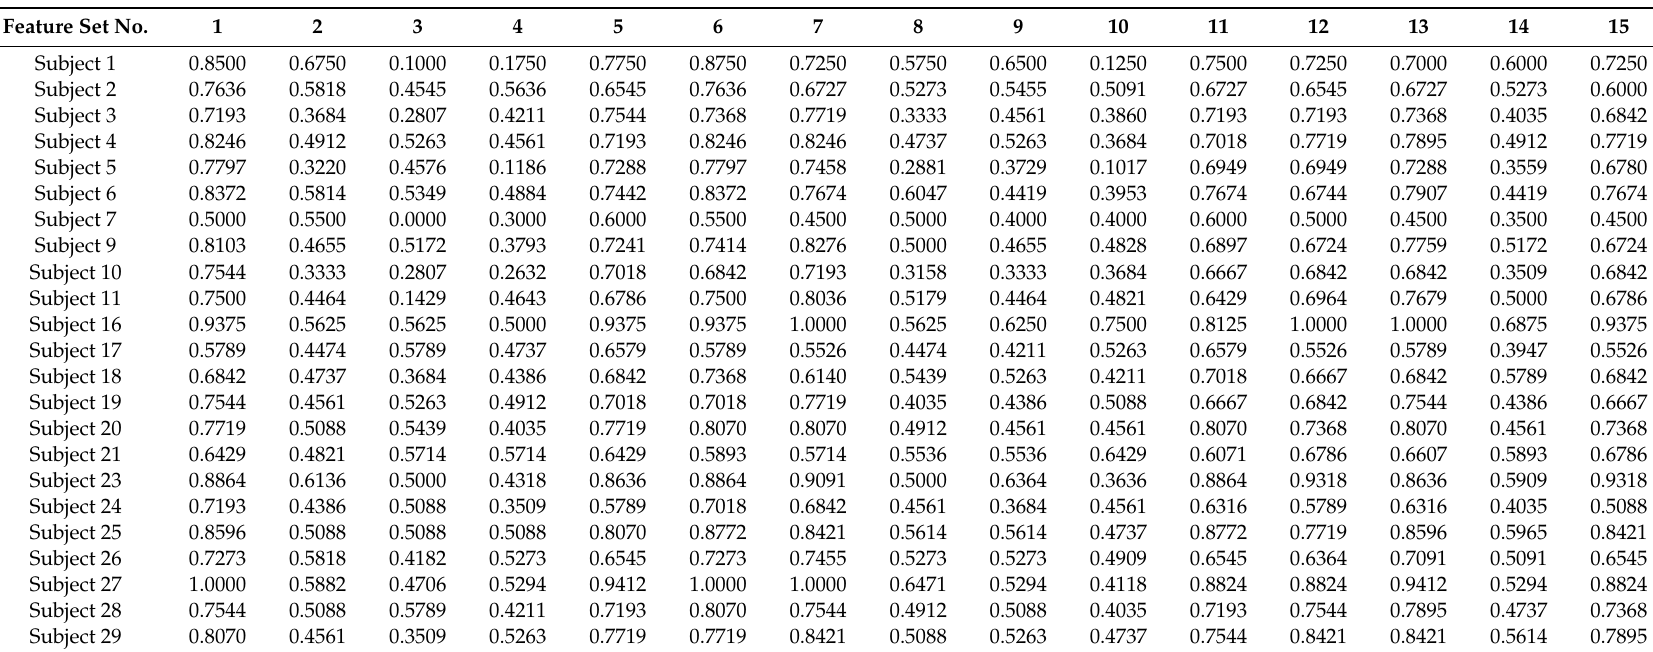
Table A2. Individual decoding accuracy for each feature set using LR classifier with LOTO method (1 s window for EEG features). Feature Set